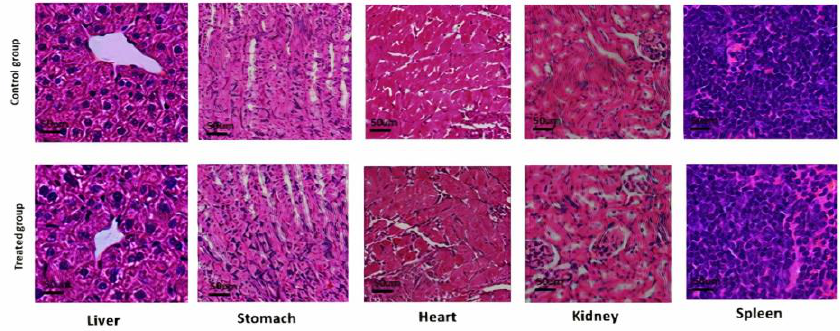
Figure 12. Histological analysis of control and TRHC-PAG-alginate treated group.